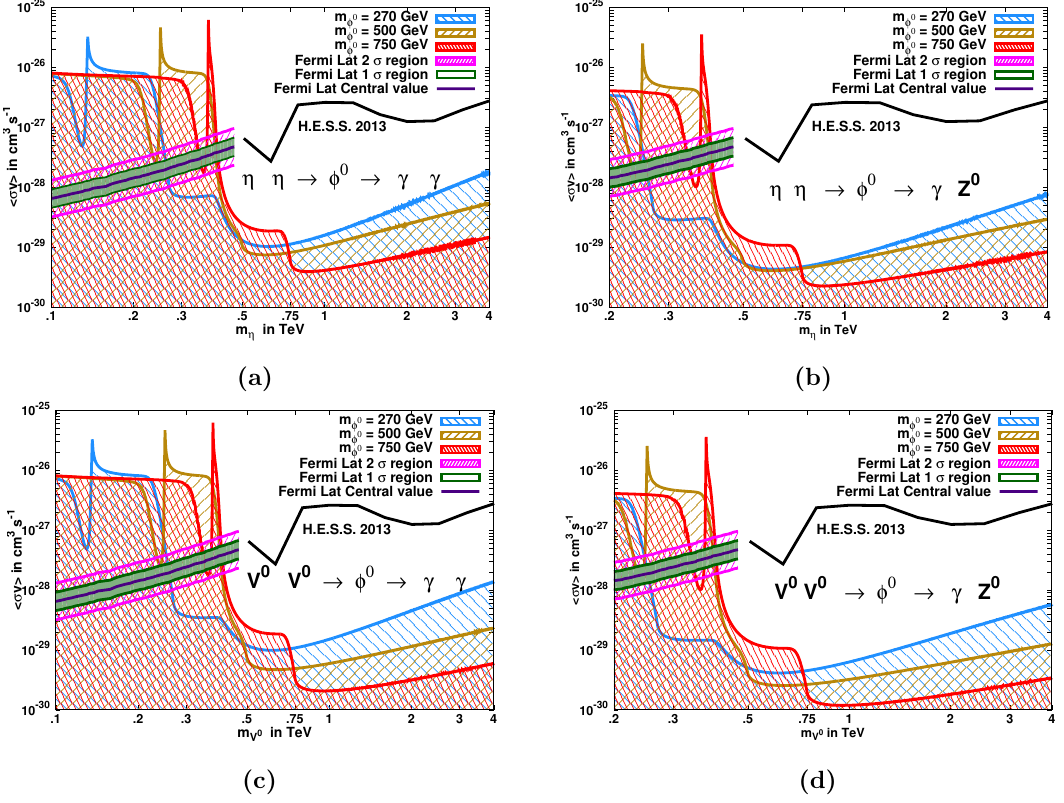
Figure 7. Figures 7a and 7b depict the thermal averaged cross-sections for scalar DM pair an- nihilation (cid:17)(cid:17) ! (cid:30) 0 ! (cid:13)(cid:13) and (cid:17)(cid:17) ! (cid:30) 0 ! (cid:13)Z processes via scalar portal respectively. Figures 7c and 7d show the thermal averaged cross-sections for vector DM pair annihilation V 0 V 0 ! (cid:30) 0 ! (cid:13)(cid:13) and V 0 V 0 ! (cid:30) 0 ! (cid:13)Z processes via scalar portal respectively. All the cross-sections are drawn for the upper limit on DM couplings allowed by the relic density constraints for a given DM mass. We have also exhibited the Fermi-LAT 1 (cid:27) and 2 (cid:27) limits for DM mass range < 500 GeV [13] and H.E.S.S. 2013 upper limit on the thermal averaged cross-section for DM mass range > 500 GeV [15] corresponding to (cid:13)(cid:13) and (cid:13)Z channels. Shaded regions appearing in blue, golden yellow and red correspond to the relic density forbidden regions for the portal mass of 270, 500 and 750 GeV